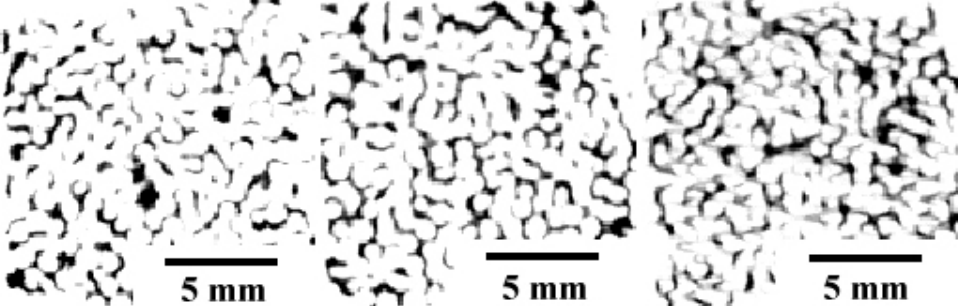
Figure 3. Image patterns obtained by tomography for three planes of a single 60-ppi sample.